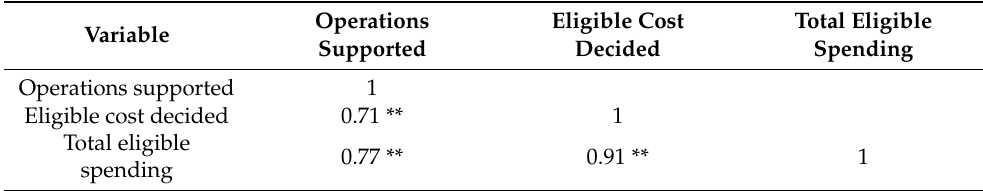
Table 4. Correlation